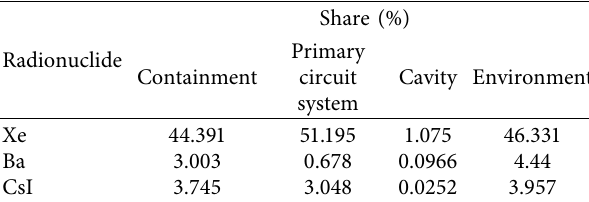
Table 5: Distribution of maximum radionuclide release share.